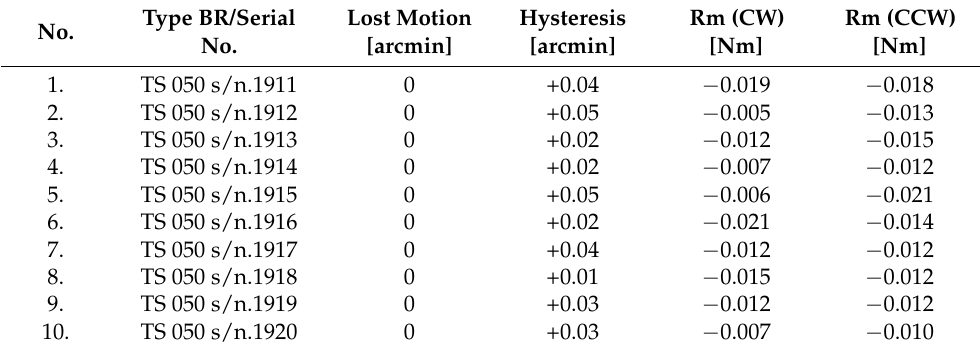
Table 11. Difference of measured parameters LR 050 before and after the trial run (configuration